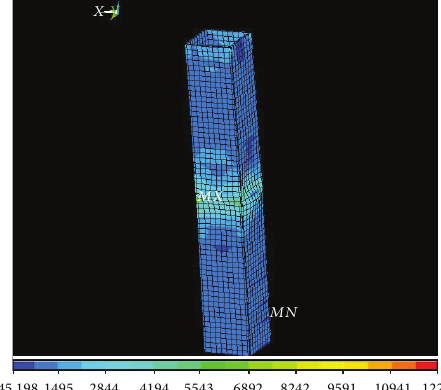
Figure 28: Typical computed deformed shapes of